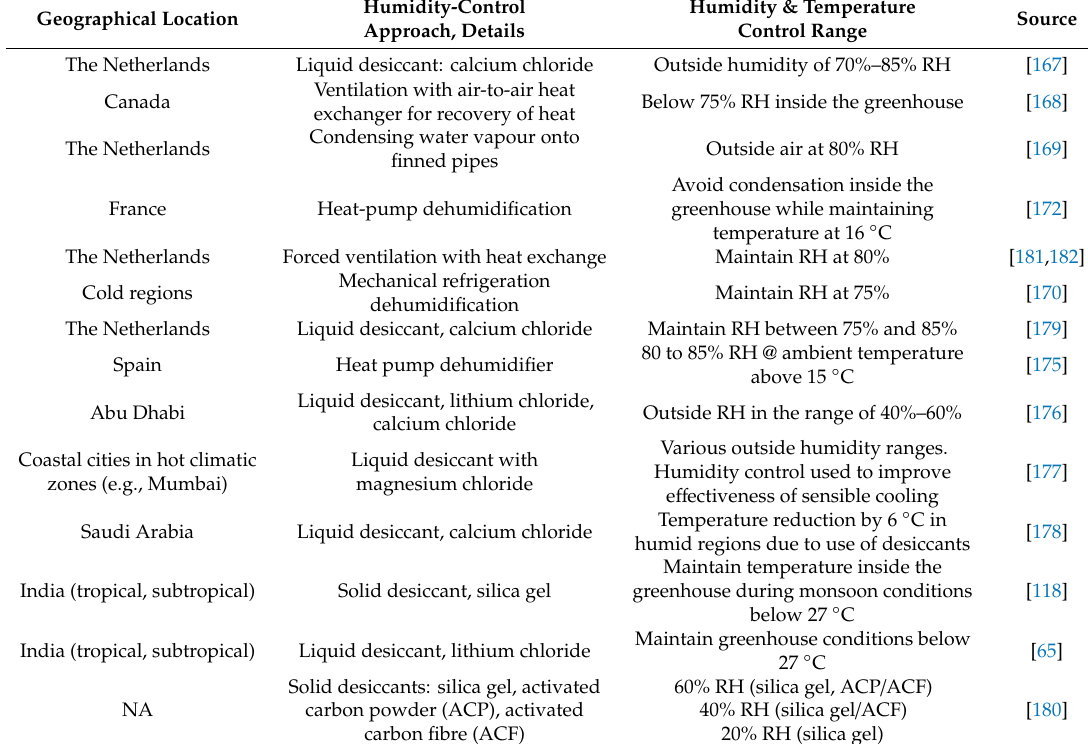
Table 2. Summary of studies related to relative humidity (RH) and temperature approaches used in di ff erent geographical locations with varying climatic